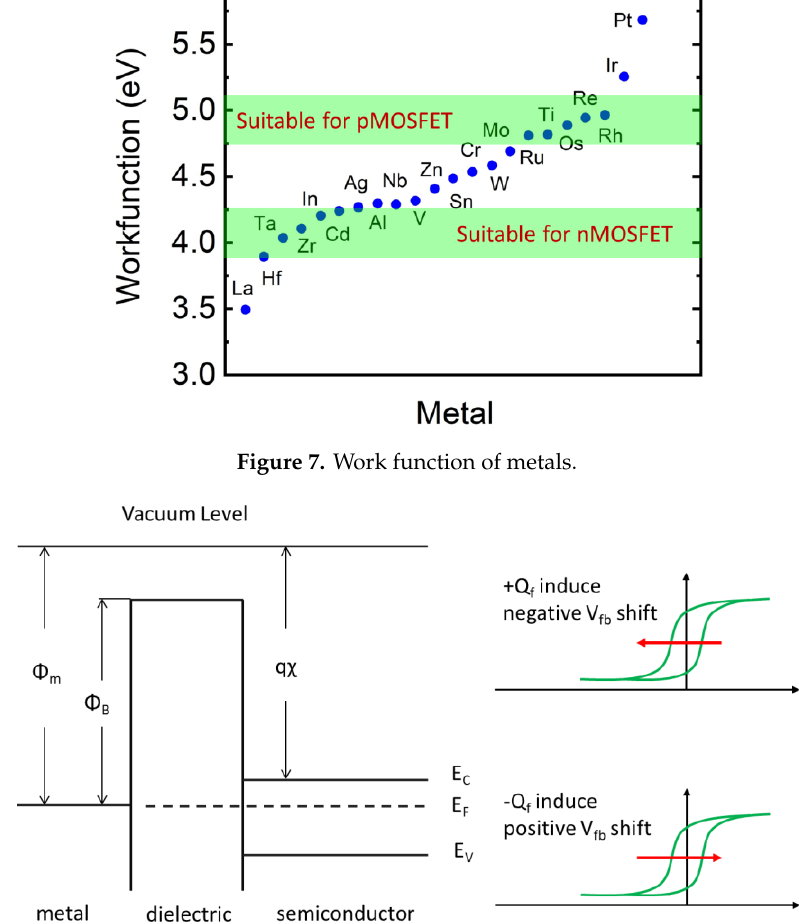
Figure 8. Flatband conditions of MOS structure for n-type substrate.